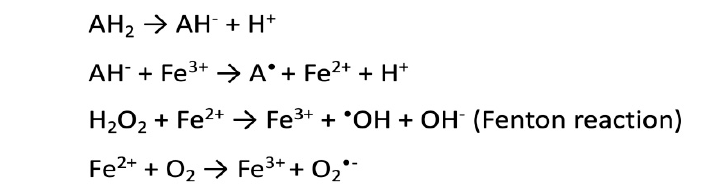
Figure 2. Scheme of hydroxyl radical generation according to Fenton’s predictions. AH 2 —ascorbic acid; AH − —ascorbate anion; A • —ascorbyl radical; • OH—hydroxyl radical; O − 2 —superoxide anion.